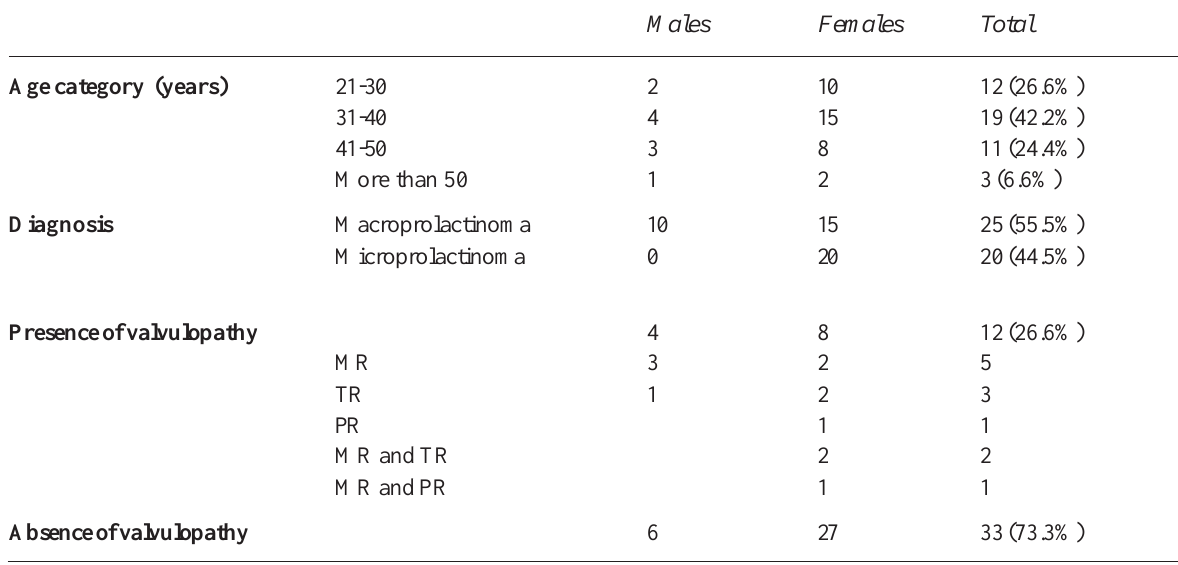
Table 1. Age category, diagnosis and proportions of valvulopathy in the sample patients